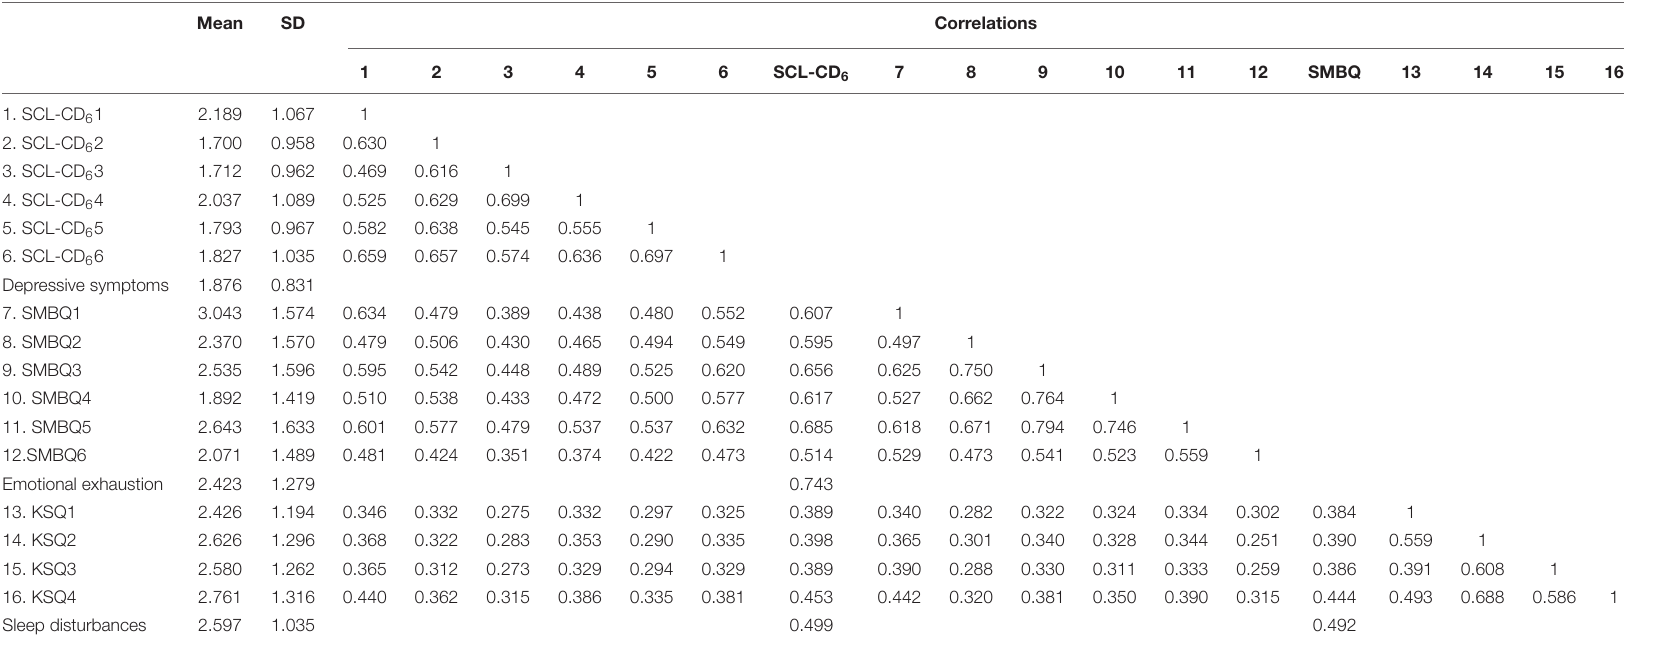
TABLE 2 | Means, SDs, and correlations for all items and indexes for the full sample ( N = 15,605; all correlations: p = 0.000). Mean SD